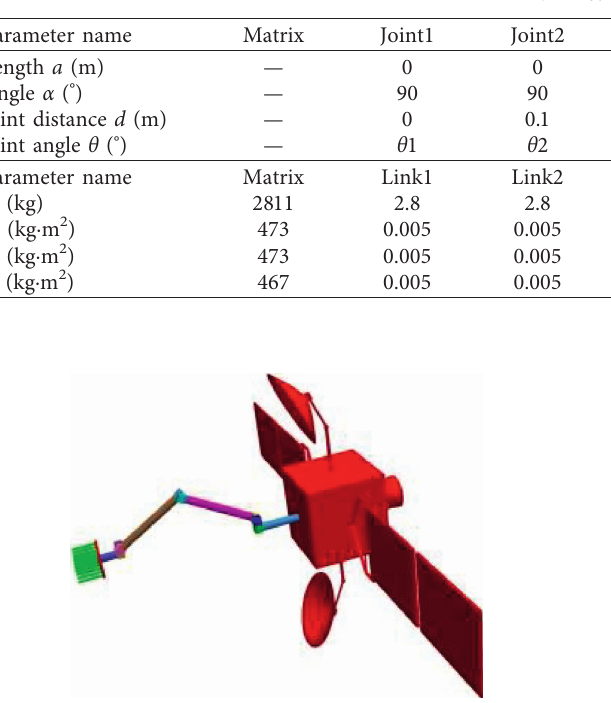
Figure 1: Structure of space robot. Table 1: Kinetic parameters.